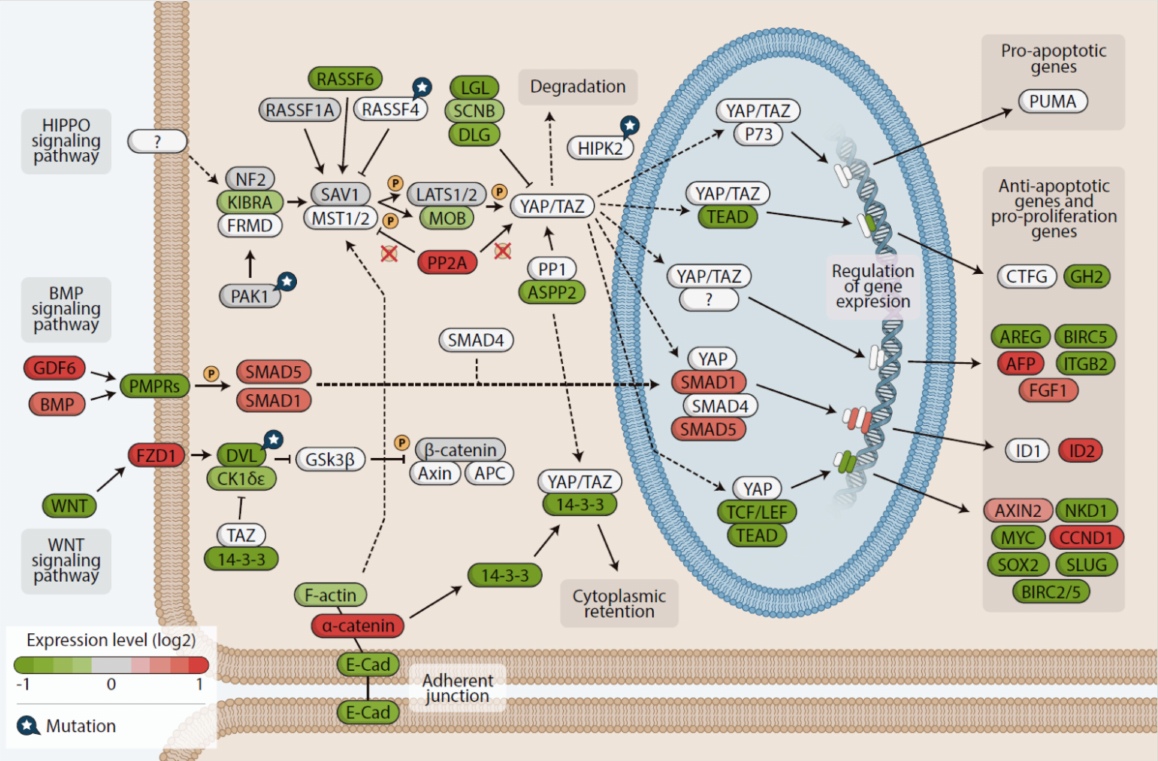
Figure 7. Hippo signaling pathway KEGG-based map, showing genes up- (red) and downregulated (green) detected by differential expression (adjusted p -value ≤ 0.05) performed in both the RAS -positive discovery cohort and RAS -positive TCGA